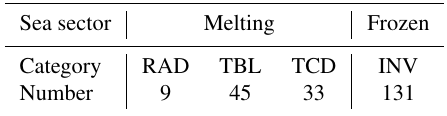
Table 2. Number of WaMAIs with boundary-layer energy-budget pattern of category RAD (radiation-dominated), TBL (turbulence- dominated), TCD (turbulence-dominated with cold dome), and INV (lifting temperature inversion) over melting (Barents) and frozen (Laptev, East Siberian, Chukchi and Beaufort) sea